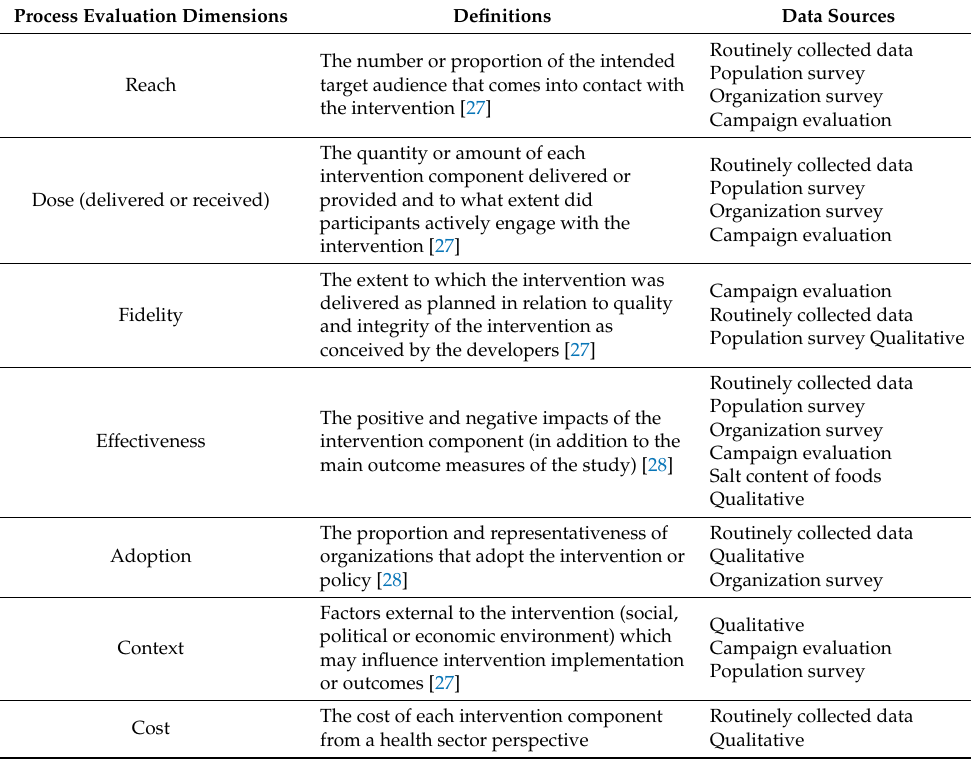
Table 1. Summary of process evaluation dimensions assessed and the data